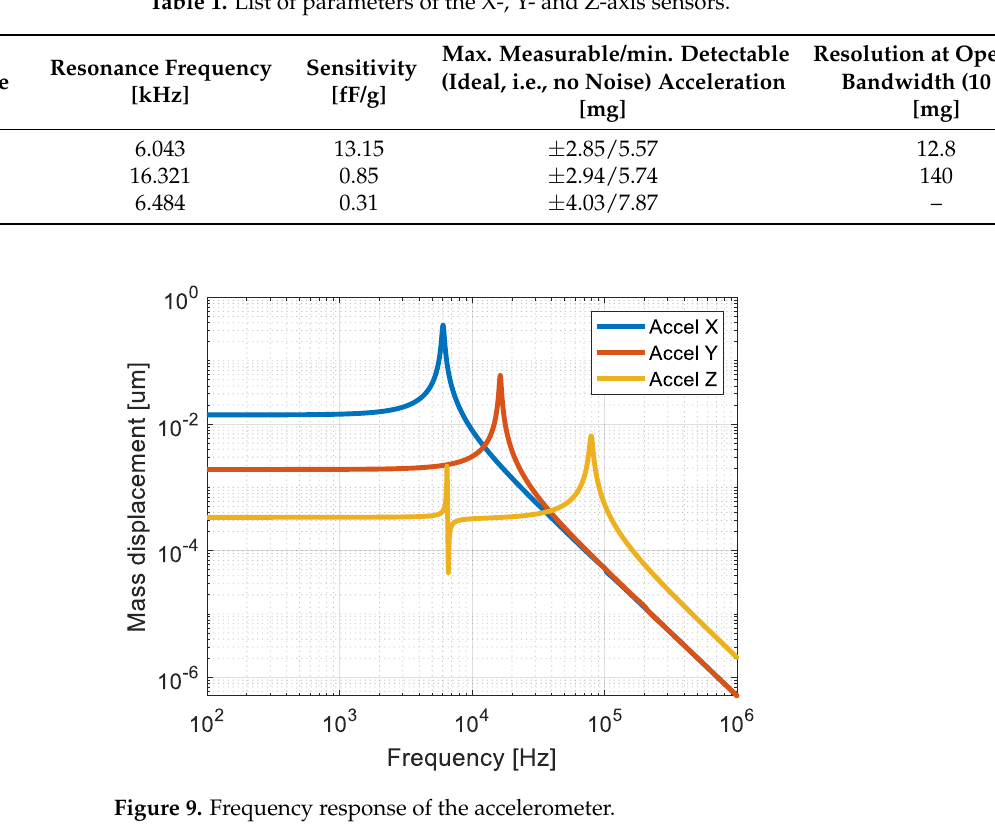
Table 1. List of parameters of the X-, Y- and Z-axis sensors.